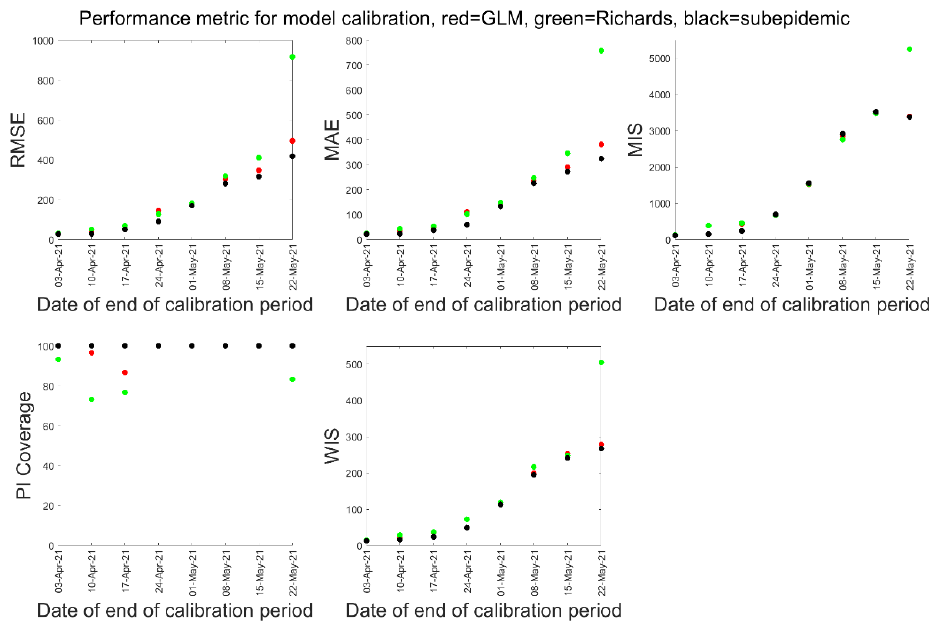
Figure 2. Comparison of performance metric during model calibration. Red dots indicate perfor- mance of the GLM model, green dots indicate performance of the Richards model, and the black dots indicate performance of the sub-epidemic